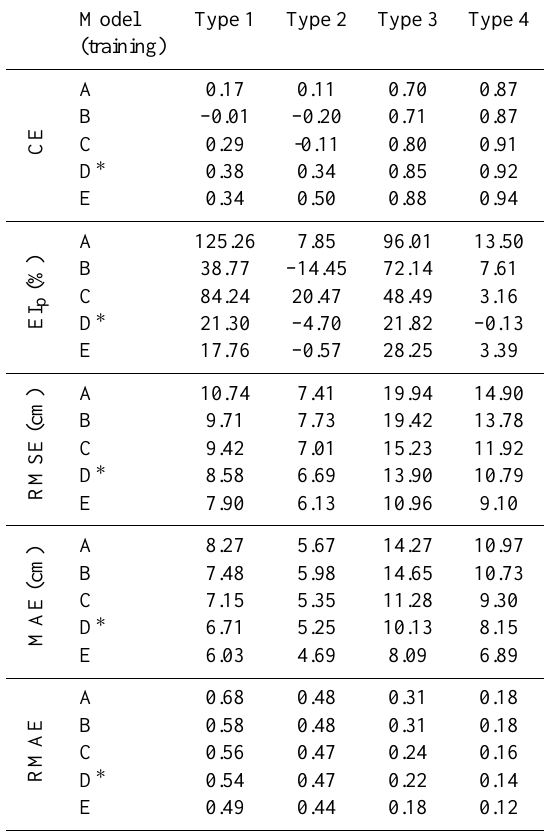
Table 4. Performance of RiHNNs for the four types of rainfall in calibration